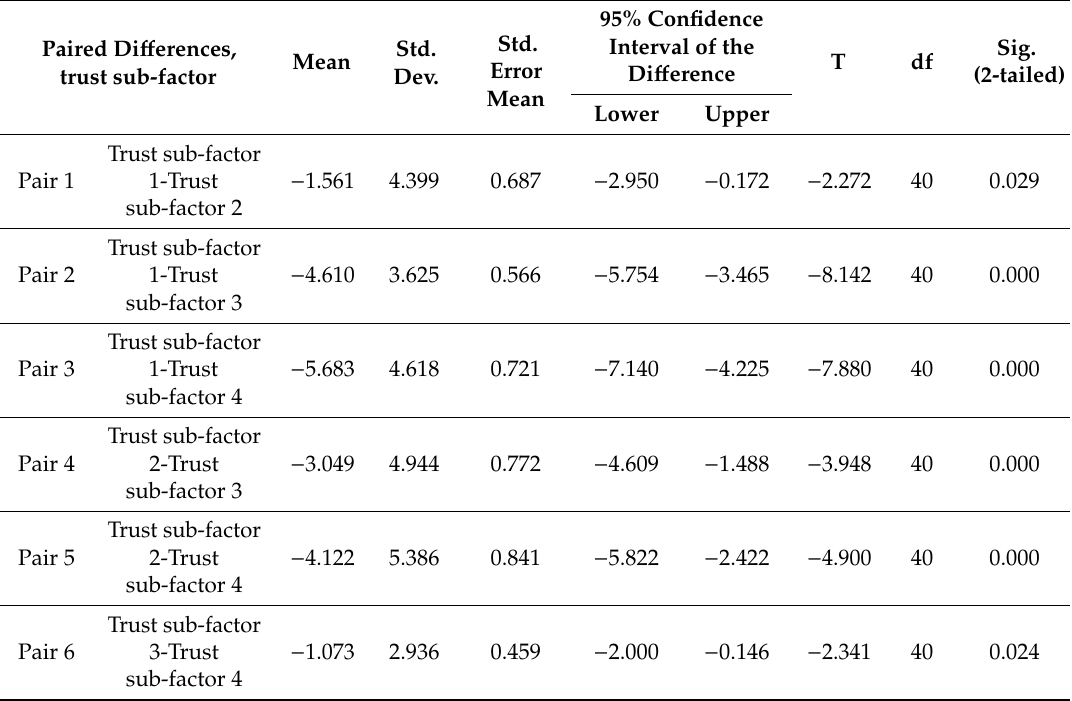
Table 4. Post-hoc tests for the Trust